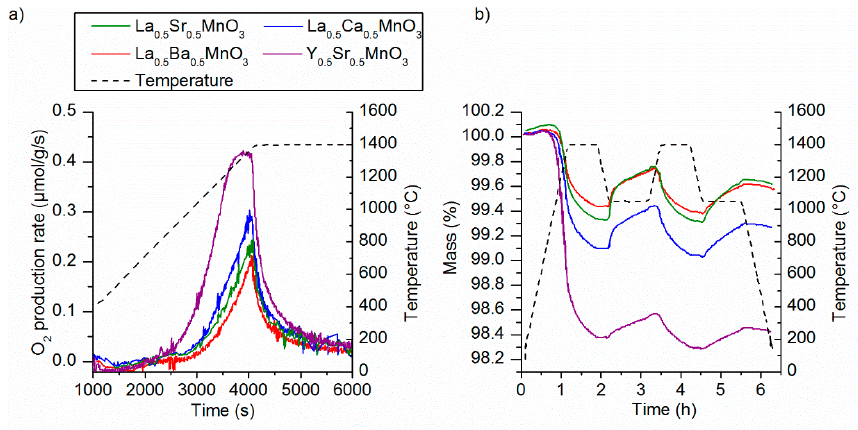
Figure 5. ( a ) O 2 production rates derived from thermogravimetric analysis (TGA) data for La 0.5 Ca 0.5 MnO 3 , La 0.5 Ba 0.5 MnO 3 , Y 0.5 Sr 0.5 MnO 3 , and La 0.5 Sr 0.5 MnO 3 , ( b ) TGA of the same